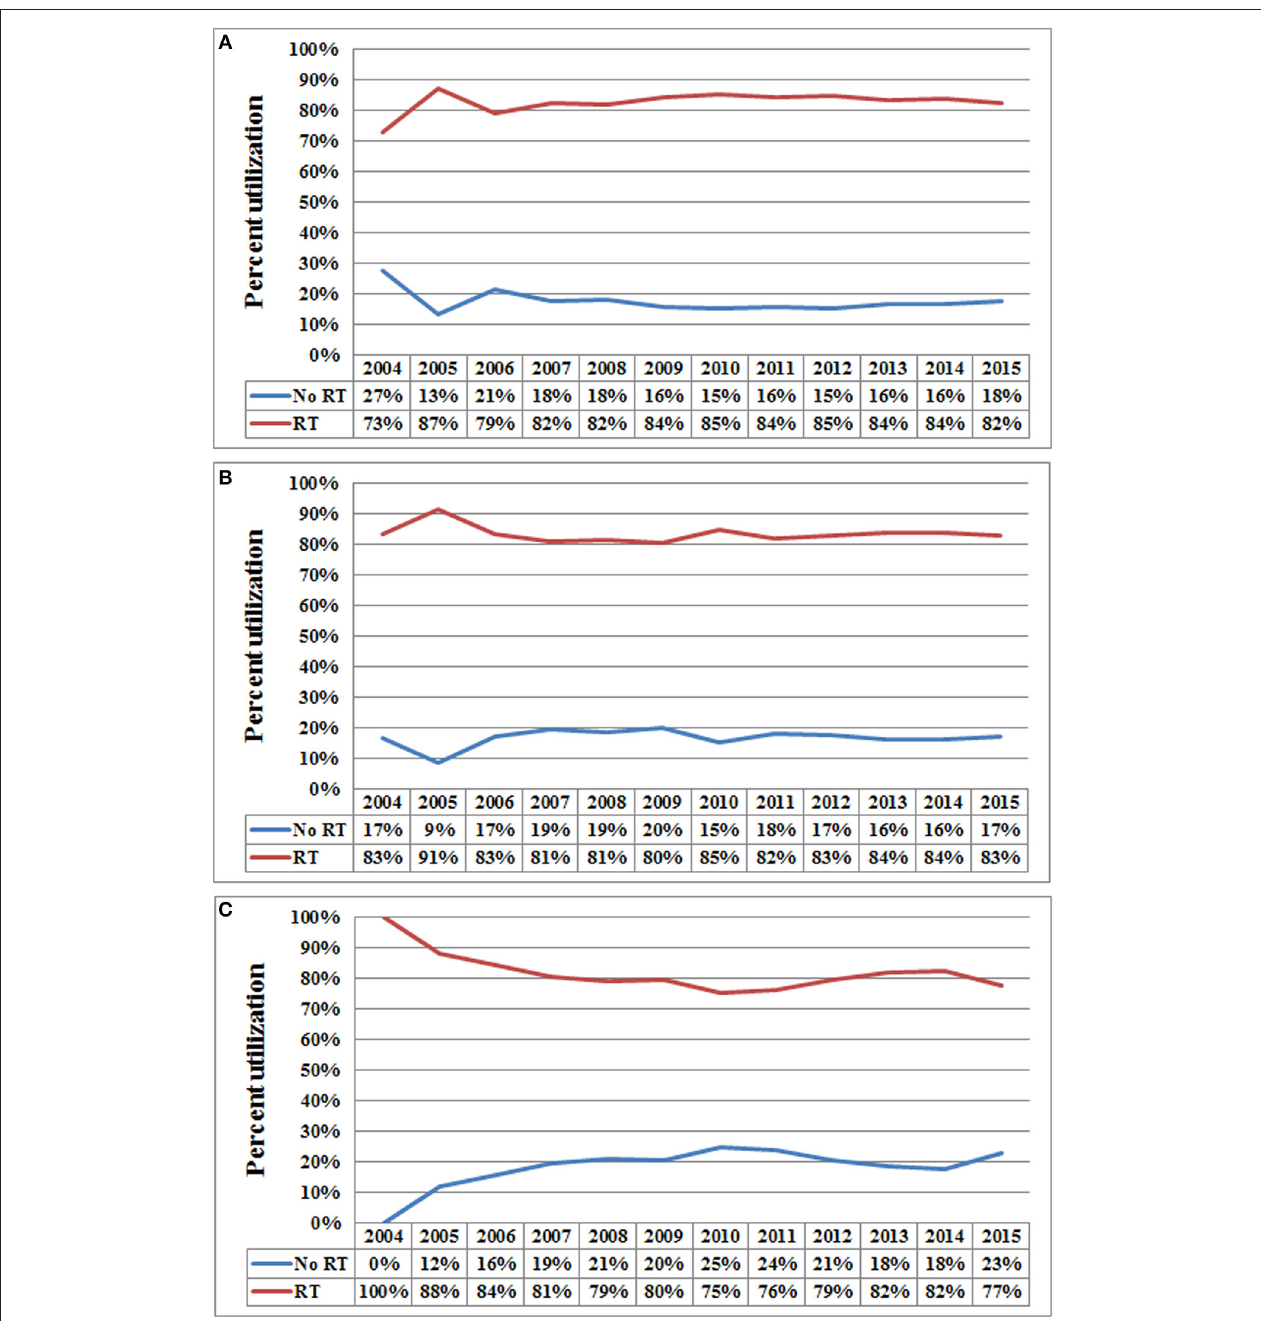
FIGURE 1 | Use of postoperative radiotherapy vs. non-use of postoperative radiotherapy over time ( A , low-risk RS group; B , intermediate-risk RS group; C , high-risk RS group).